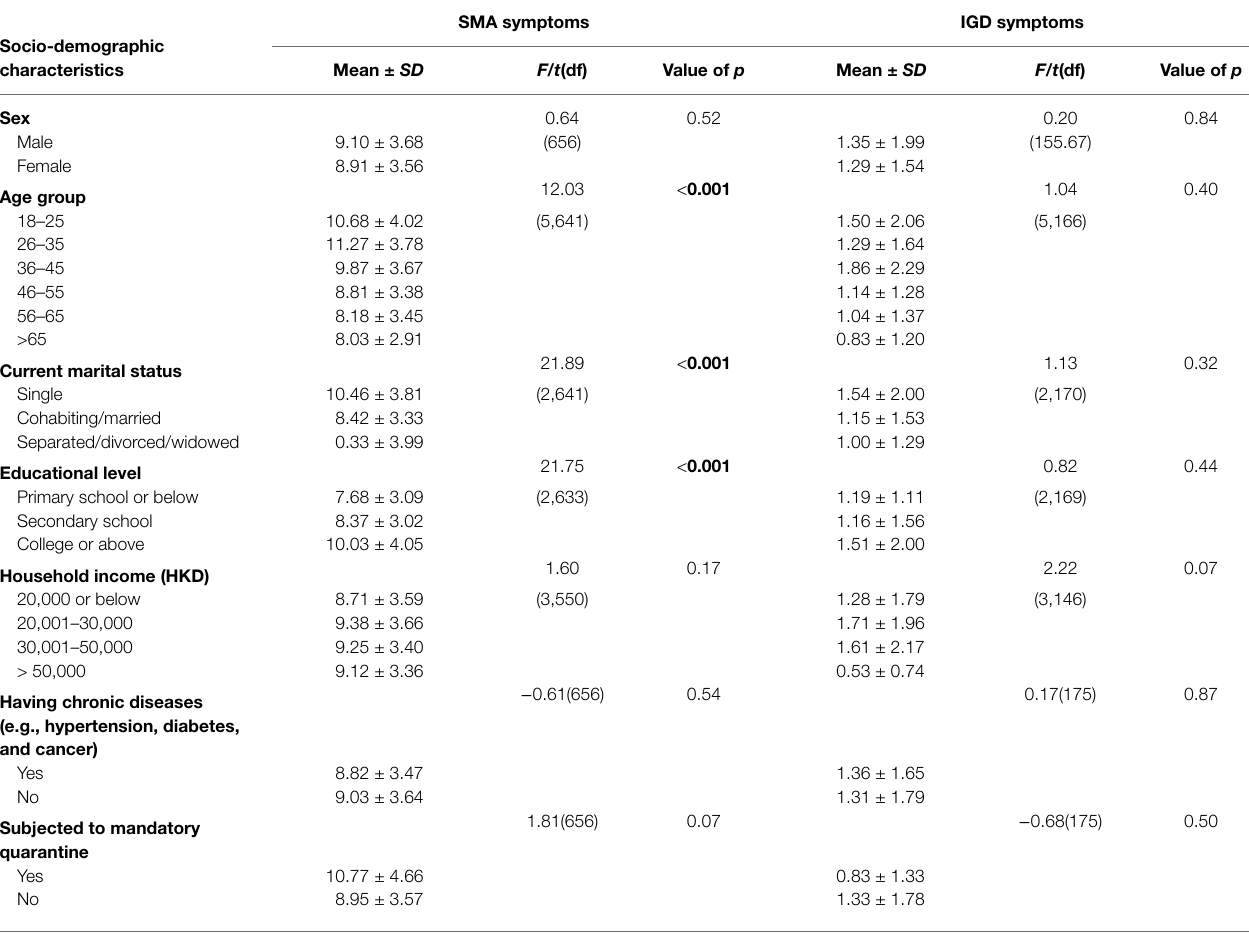
TABLE 2 | The levels of social media addiction and Internet gaming disorder symptoms by socio-demographic